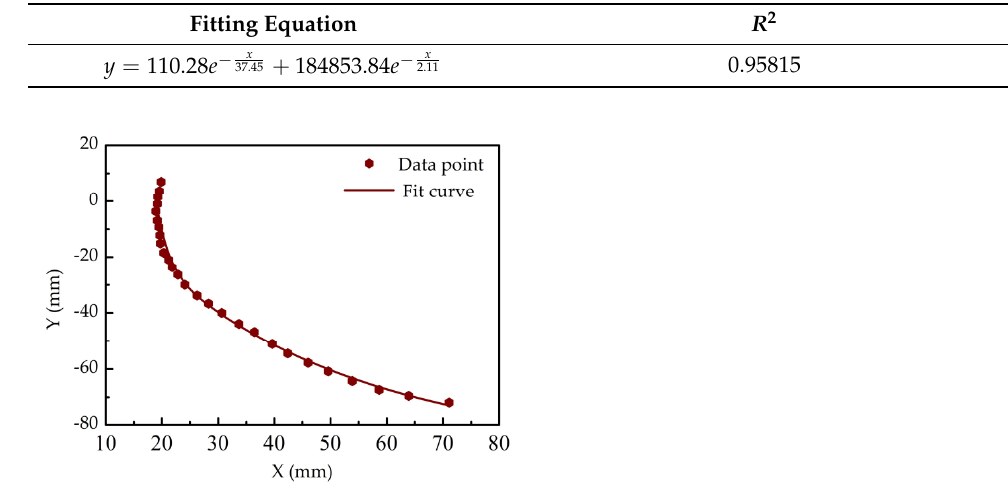
Table 5. Comparison between DEM virtual simulation test results and indoor soil bin test